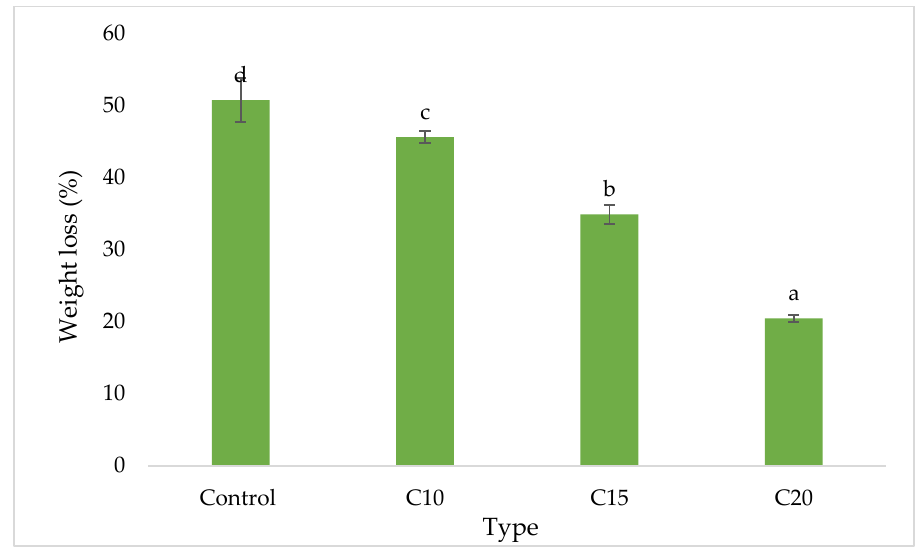
Figure 6. Weight loss of particleboard samples after 4-week exposure to Coptotermus curvignathus. Note: Means followed by the different letters a, b, c and d are significantly different at p ≤ 0.05. CA10 = 10 wt% citric acid, CA15 = 15 wt% citric acid, CA20 = 20 wt% citric acid. Citric acid has been reported as an effective natural wood preservative. Tarasin and